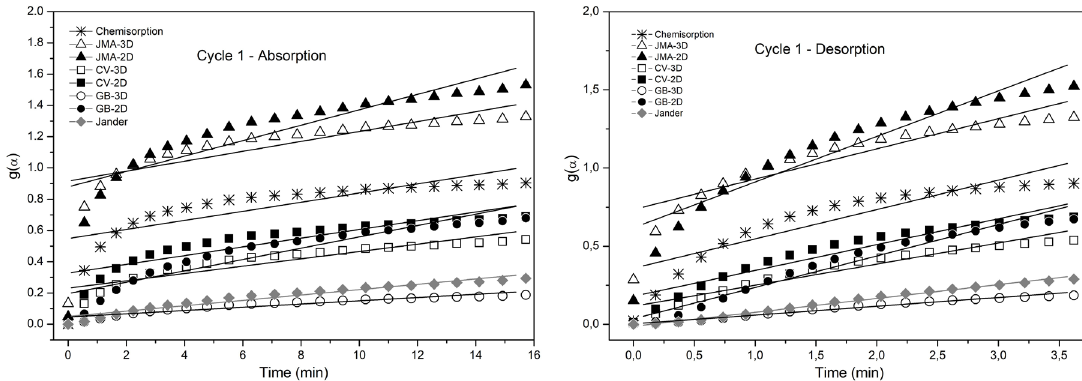
Figure 5. Linear fitting of the rate-limiting step models for the first hydrogenation and dehydrogenation of cold-rolled TiFe IMC.